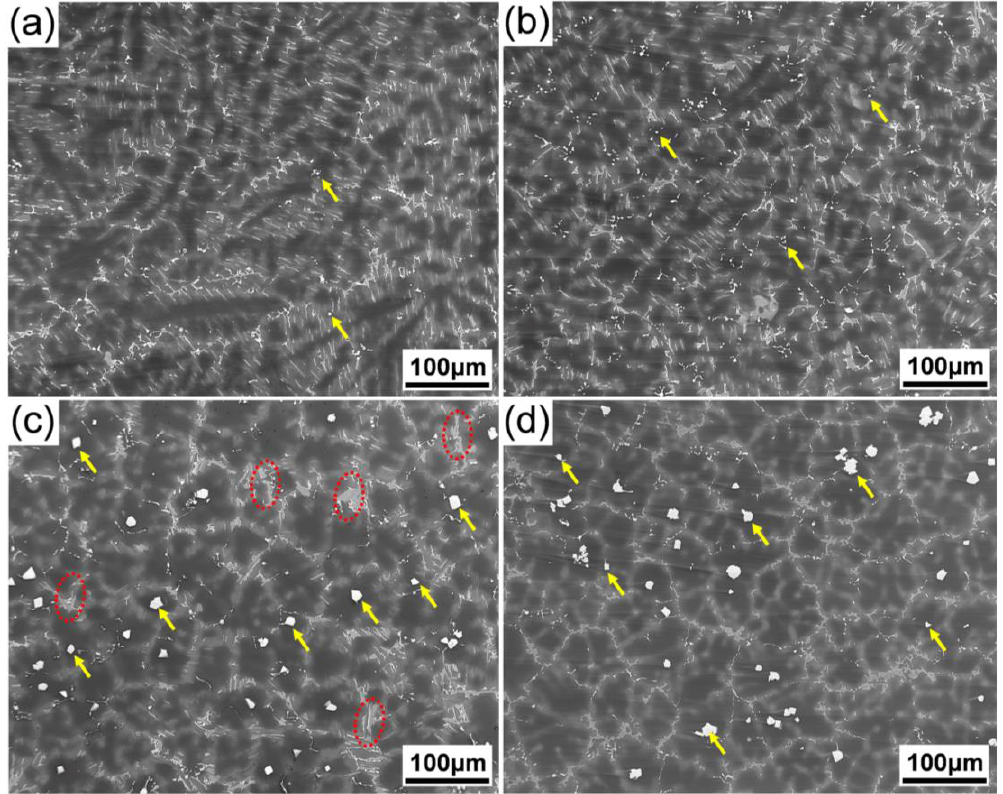
Figure 2. SEM micrographs of the as-cast alloys: ( a – c ) 0.5Zn-xAl (x = 0.2, 0.5, and 1.0); ( d ) 0Zn-1.0Al.